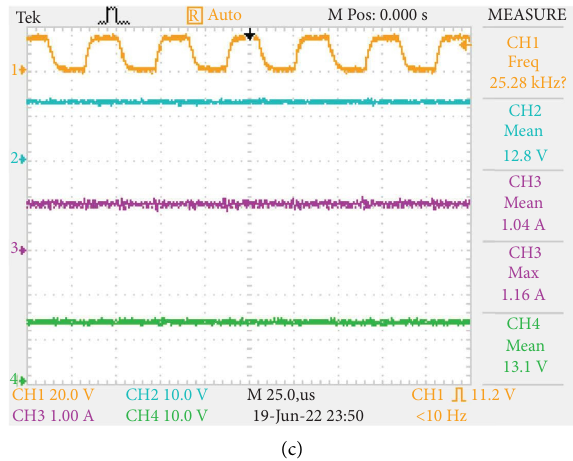
Figure 22: (a) PWM, V in , I L 1 , and V o ; (b) PWM, V in , I in , and V o (c) PWM, V in , I o , and V o Cuk converter with LCL flter. Table 2: Comparison of the flter with respect to controller gain, flter attenuation, and maximum gain. LC LC with damp Control gain Attenuation by decade (dB) 40 Max. gain at corner freq. Table 3: Comparison of the DM noises for each flter. Magnitude (dB)